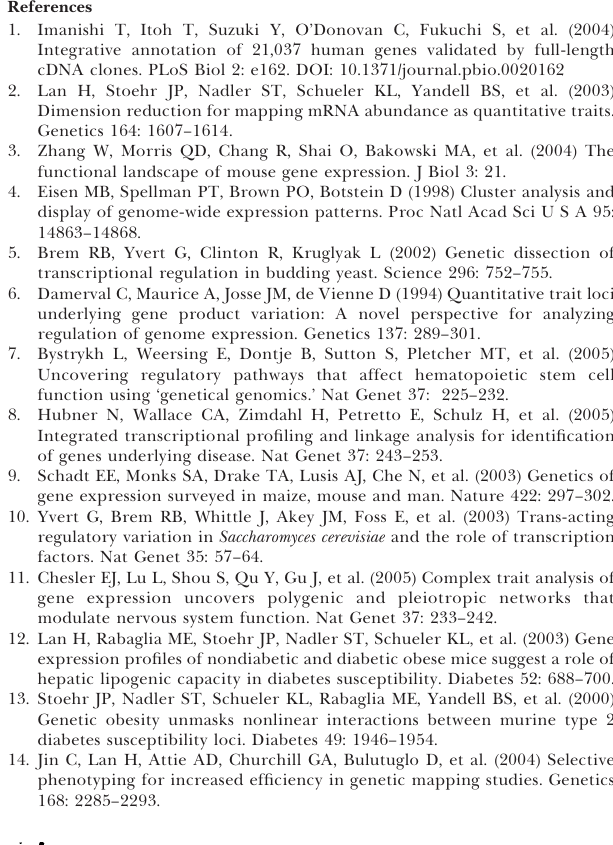
Table S6. Descriptions of the Gene Ontology ‘‘ BP ’’ Terms That Are Enriched in the 174 GPCR Protein Signaling Pathway Traits Columns A and B show the GO category identifiers and the names. Column C shows the enrichment P- values (rounded to five decimal places) calculated using Hypergeometric distribution. Column D shows the GO category size. The Gene Ontology (www.geneontology.org) accession numbers are GPCR protein signaling pathway (0007186) and Scd1